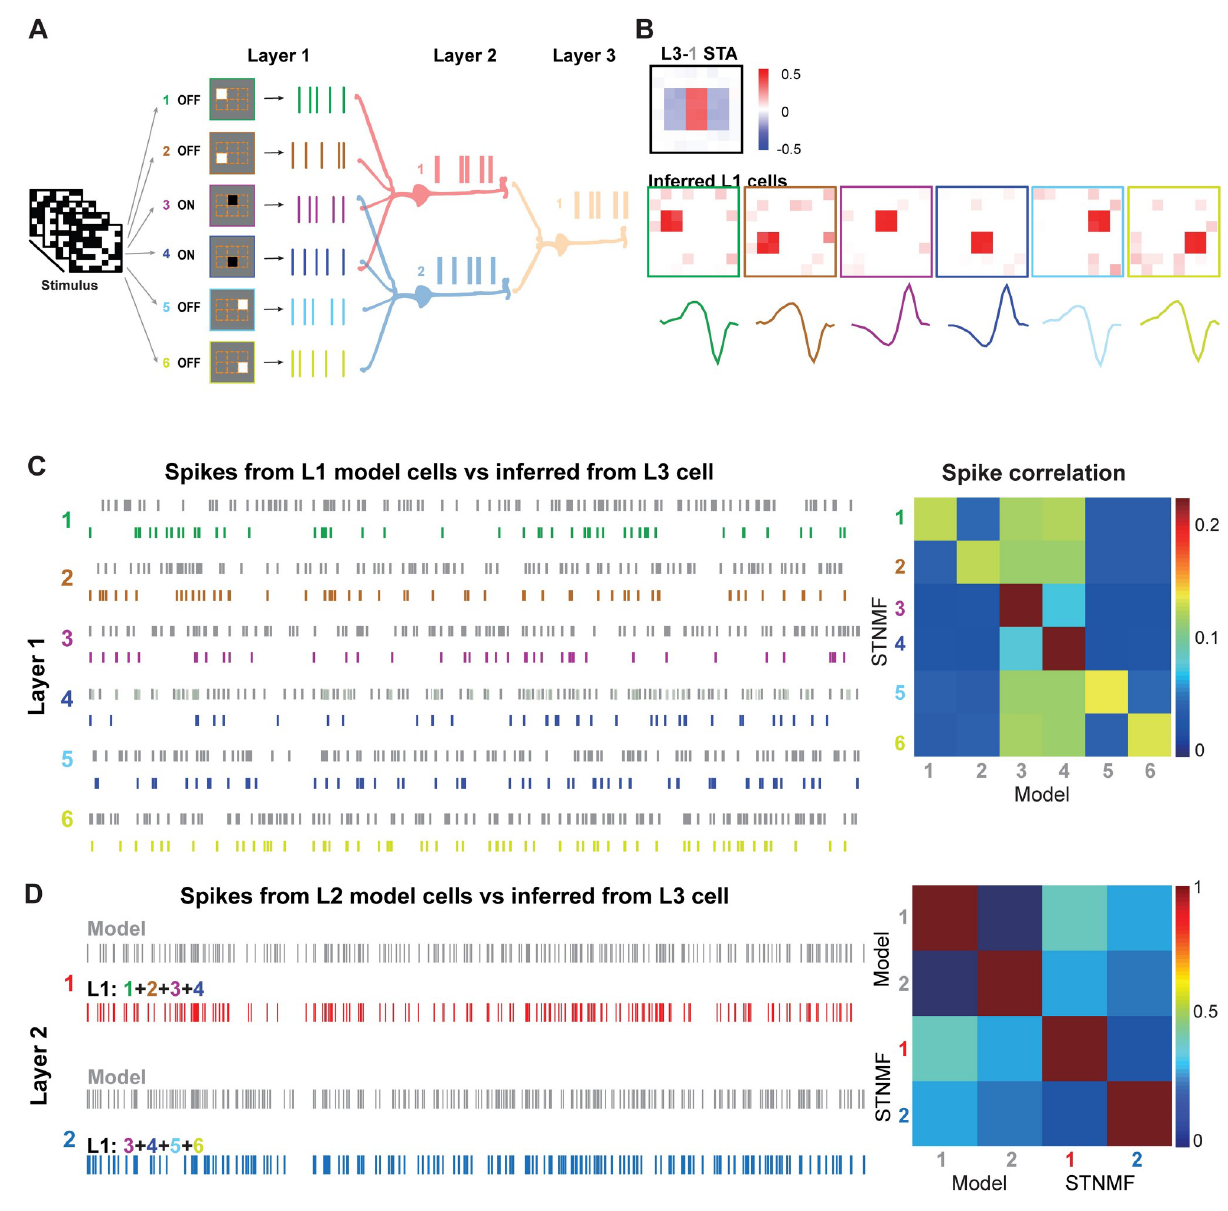
Fig 6. STNMF analysis of a V1 simple cell. (A) Illustration of a model simple cell as a 3-layer neural network with ON and OFF cells. (B) ON and OFF cells are separated from STNMF. The RF of the simple cell computed by STA. RFs of layer 1 cells were identified as STNMF subunits with their corresponding temporal filters. (C) (Left) Spike trains generated from layer 1 model cells 1–6 (gray) and inferred from layer 3 cell by STNMF (colored). (Right) Matrices of corresponding correlation of spike trains between model and STNMF inference. (D) (Left) Spike trains generated from layer 2 model cells 1–2 (gray) and combined spikes inferred from layer 3 cell by STNMF (cell 1: red, cell 2: blue). (Right) correlation matrices of spike trains between model and STNMF